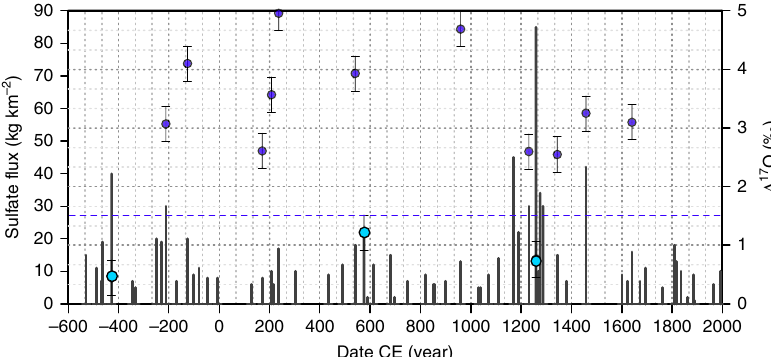
Fig. 2 Δ 17 O on 14 stratospheric events. All blue dots refer to Δ 17 O values, in per mil. The three light blue dots, standing below the Δ 17 O = 1.5 dotted line, display particularly low 17 O-excess. If two samples were measured for a same event, the smallest anomaly is displayed on the graph. Data are not corrected from background oxygen isotopic composition (see Methods for further explanations). Error bars are 1